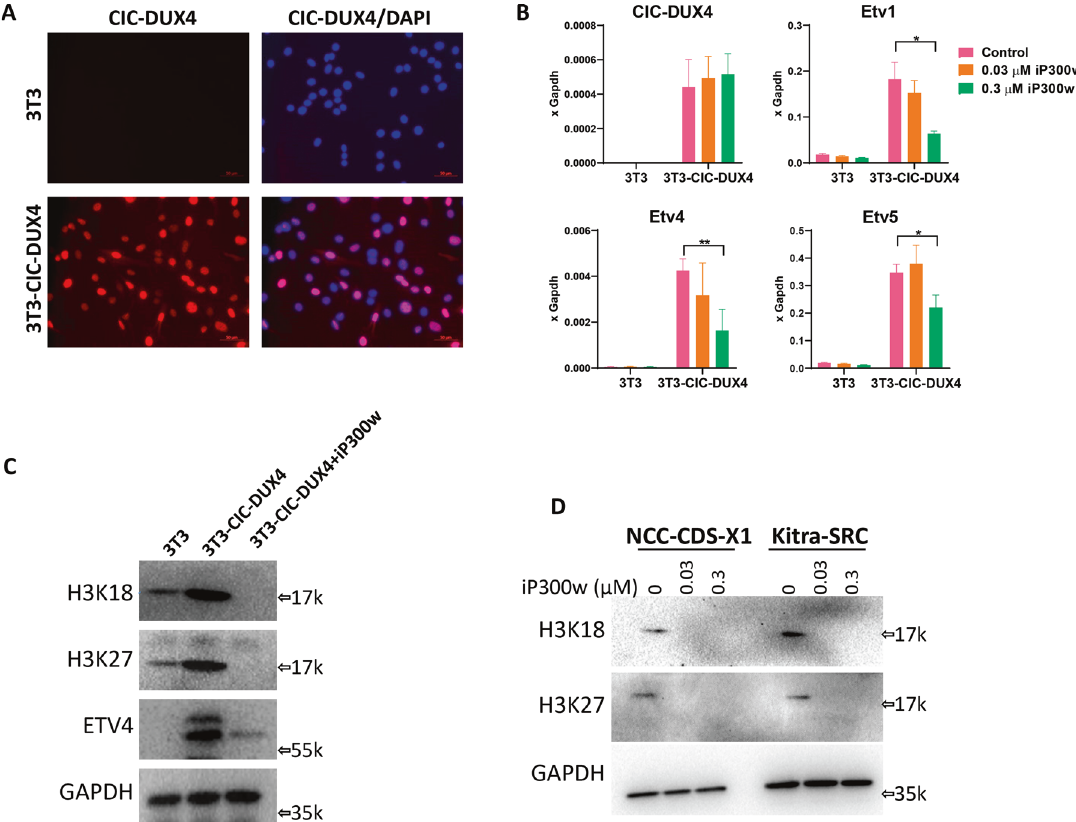
Fig. 6 CIC-DUX4 induces H3 acetylation that is reversible by iP300w. A Immunostaining for CIC-DUX4 in the 3T3-CIC-DUX4 cell line. B RT- qPCR for CIC-DUX4 and its target genes in 3T3-CIC-DUX4 cells treated for 18 h with iP300w. C Western blots for ETV4 and acetylated H3K18 and H3K27 in 3T3-CIC-DUX4 cells treated for 18 h with iP300w. D Western blots for H3 acetylation markers in CIC-DUX4 sarcoma cell lines treated for 18 h with